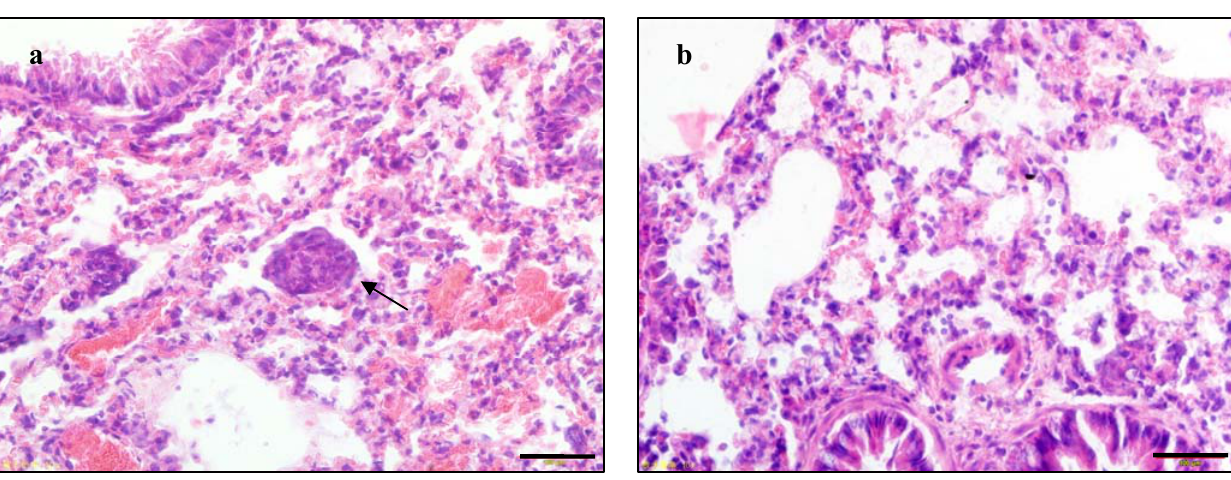
Figure 4. The representative example of pulmonary metastasis ( a , arrow indicating a metastatic tumor nodule) and non-metastasis ( b ) in the HCCLM3 xenograft model, by H&E staining. The black bar represents 100 µm.